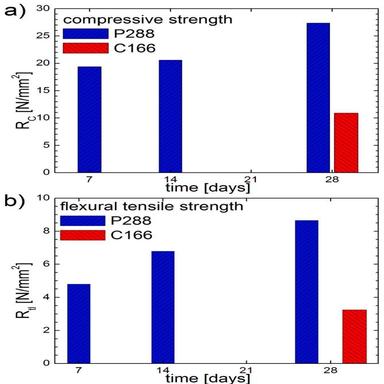
The compressive strength a) and b) flexural tensile strength measured for P288 and C166 at 7, 14, 28 days after preparation.